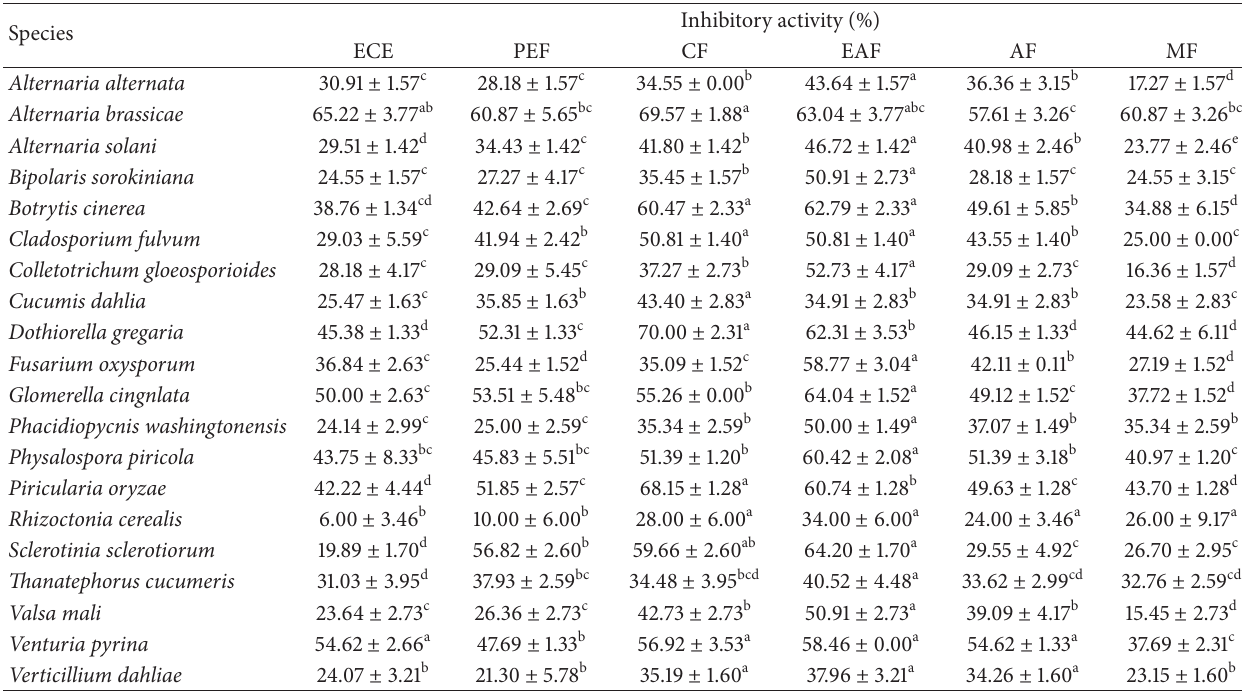
Table 5: Preliminary antifungal activity of ethanol extracts and its five fractions from Z. bungeanum leaves tested at 50mg/mL against 20 plant pathogenic fungi.